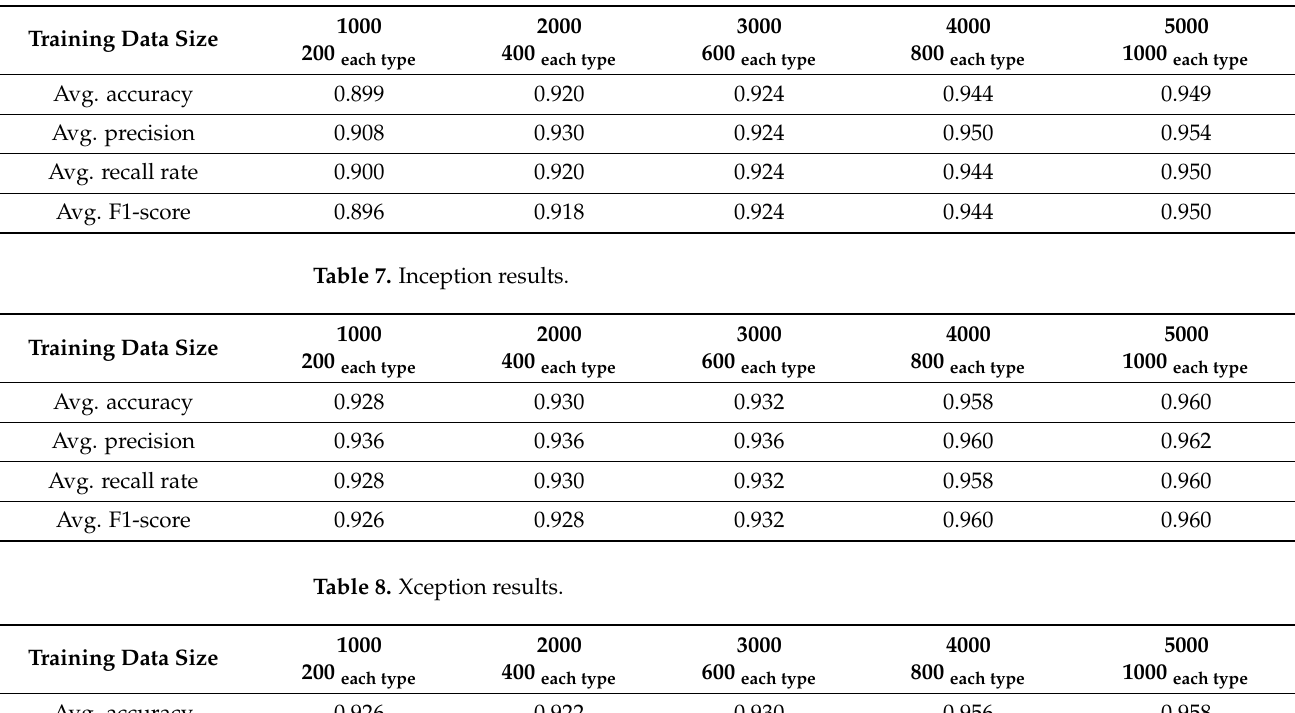
Table 6. VGG-16 results.